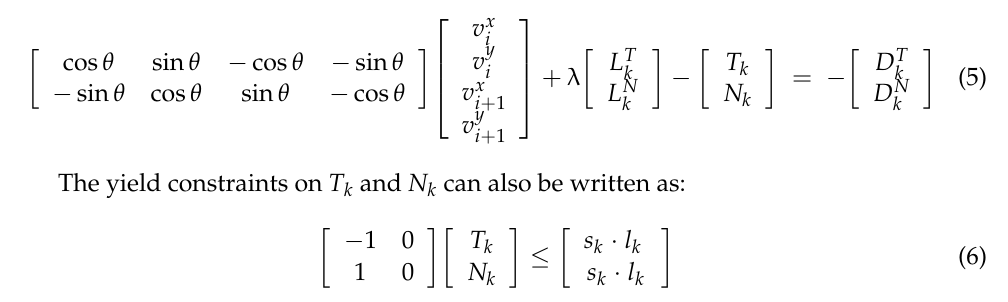
Figure 7. ( a , b ) Two subsets of initial input interfaces for complex geometries; ( c ) a set of internal and peripheral interfaces generating ( d ) invalid and ( e ) valid segments.